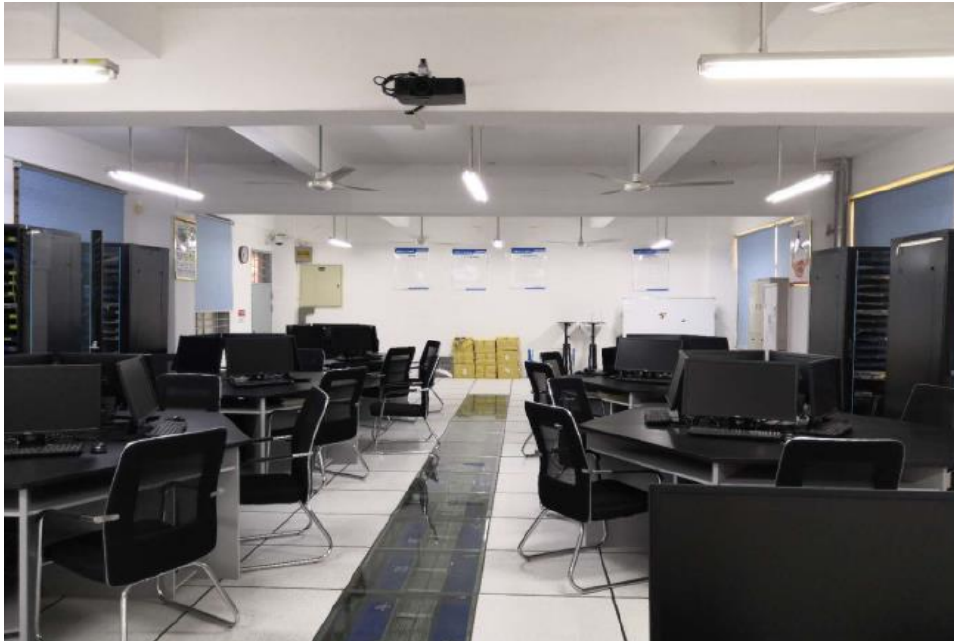
Figure 2. Experiment environment.